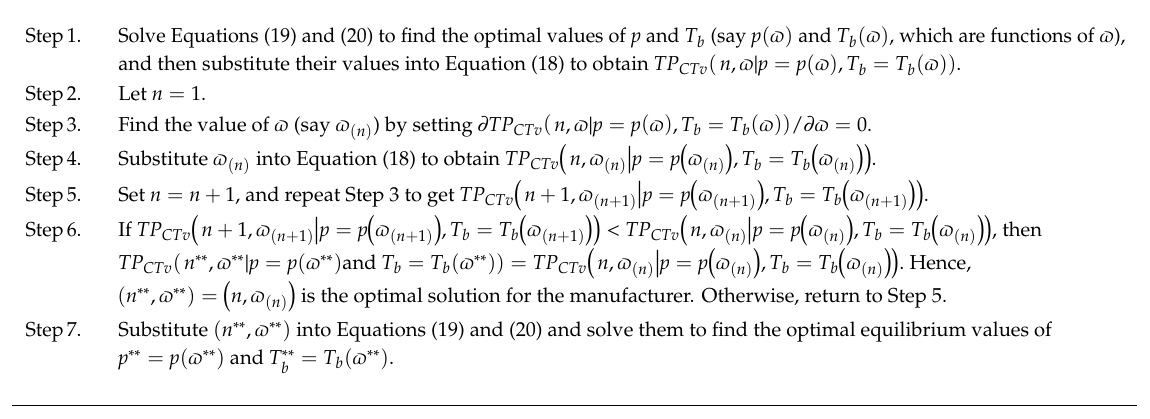
Algorithm 1. Equilibrium Solution for Stackelberg